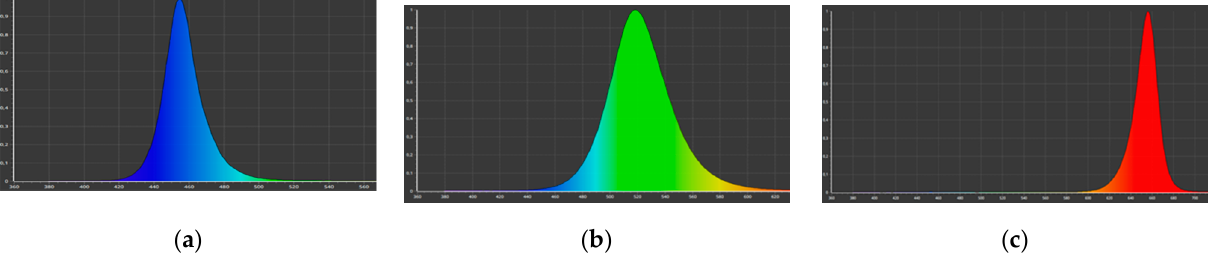
Figure 7. Monochrome LED lamps spectrum: ( a ) blue LEDs; ( b ) green LEDs; and ( c ) red